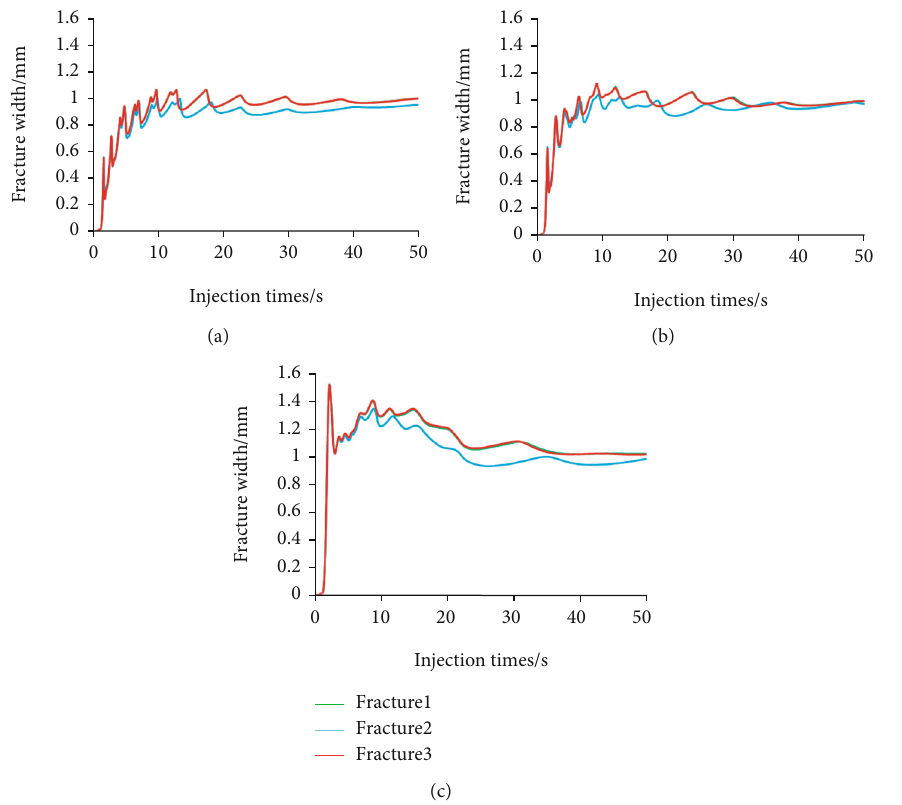
Figure 23: Maximum fracture width of each cluster as a function of time for di ff erent fracturing fl uid viscosities: (a) case 5 (1 cp); (b) case 8 (10 cp); (c) case 9